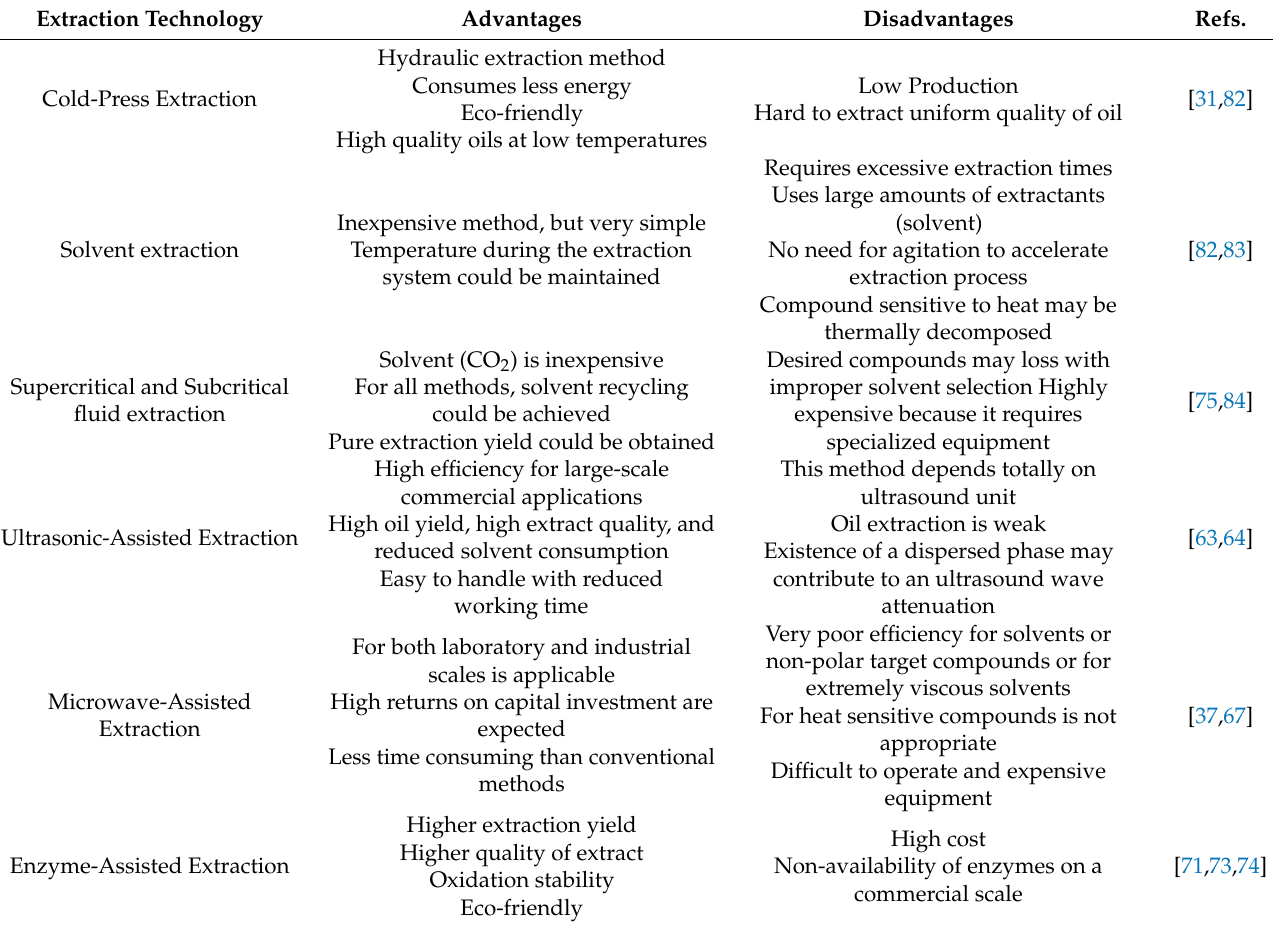
Table 2. Overview of different extraction technologies of walnut oil with advantages and disadvan- tages. References are provided for the various